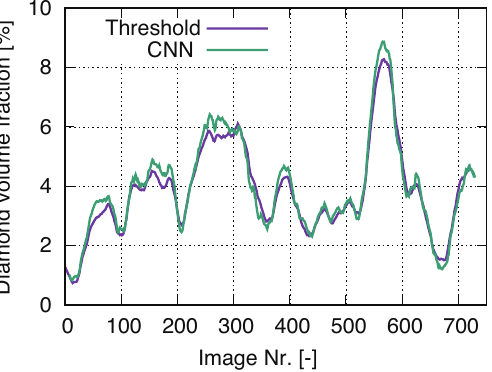
Figure 15. Comparison of diamond area fraction in each µ CT image after the segmentation: threshold method [61] vs. U-Net/ML